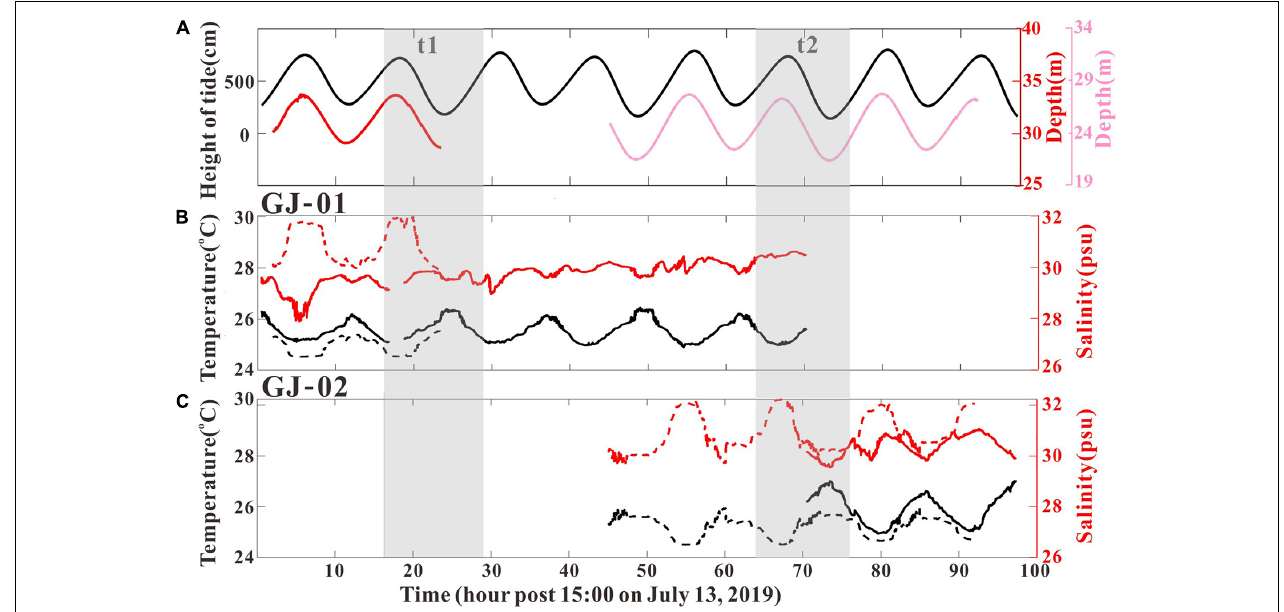
FIGURE 3 | Time series of water-level change at GJ-01 (red line) and GJ-02 (pink line), and also tidal elevation change at Bangmen tide-gauging station (black line) (A) , temperature and salinity at GJ-01 (B) , and temperature and salinity at GJ-02 (C) . Surface (Bottom) water temperature and salinity are indicated by black (black dotted) and red (red dotted) lines, respectively. The two gray-shaded periods (t1, t2) represent the periods of hourly CTD casts at GJ-01 and GJ-02, respectively.